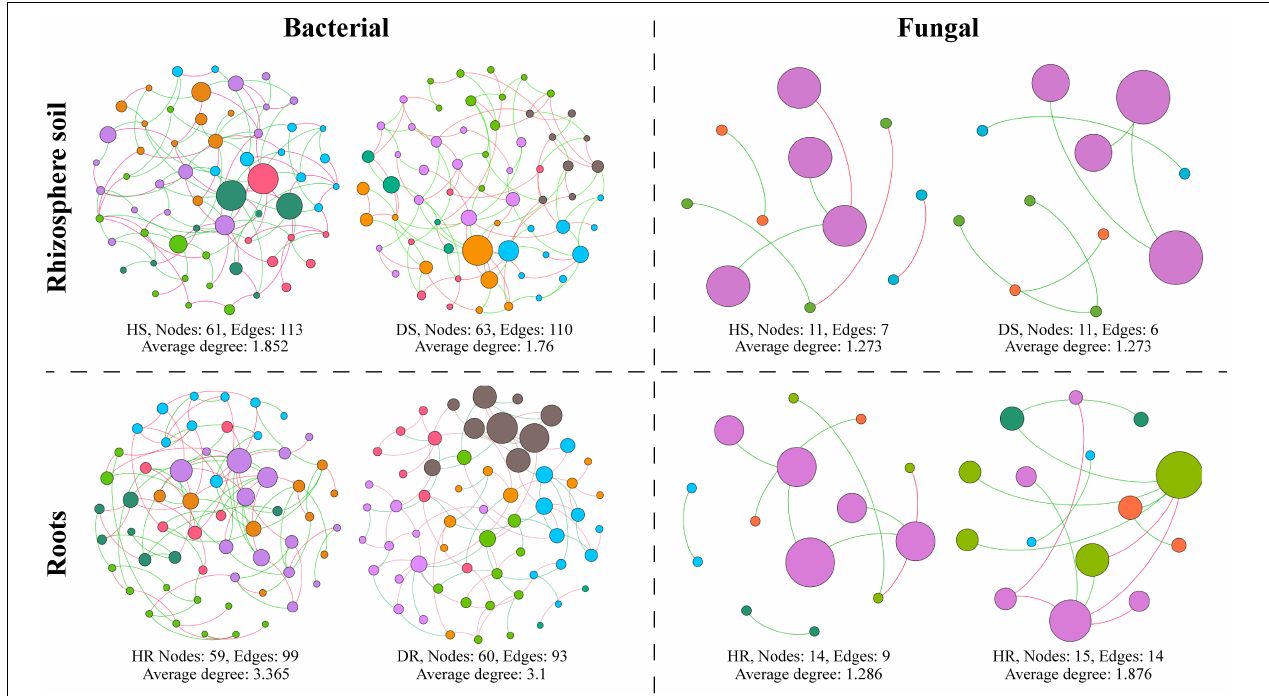
FIGURE 8 | Co-occurrence network analysis of bacterial and fungal communities associated with healthy and diseased samples collected from different plant components (rhizosphere soil and roots). HS, healthy soil; DS, diseased soil; HR, healthy roots; DR, diseased